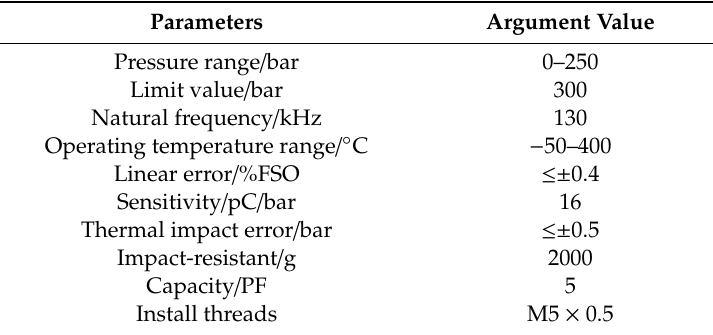
Table 2. The technical parameters of a 6052B pressure